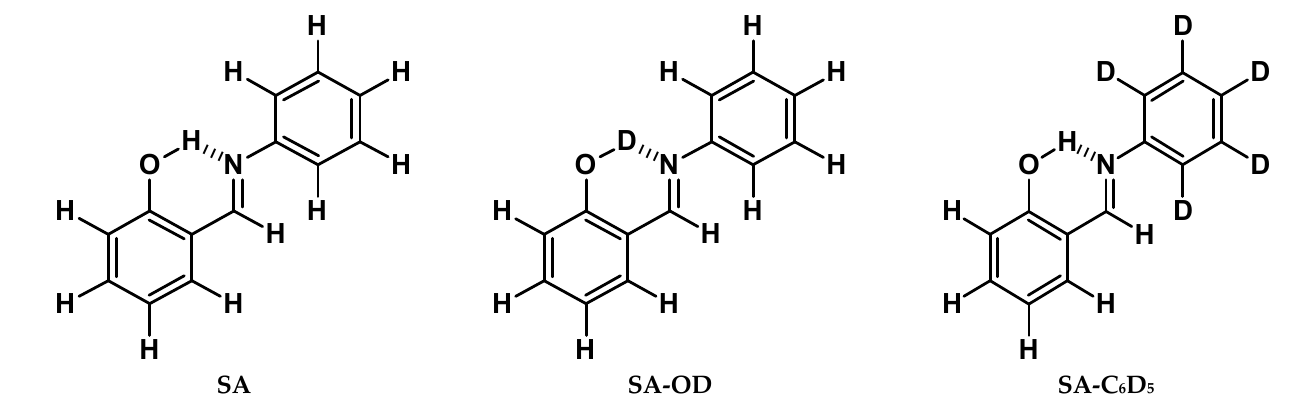
Figure 2. Structures of studied 2-[(E)-(phenylimino)methyl]phenol and its isotopologues.